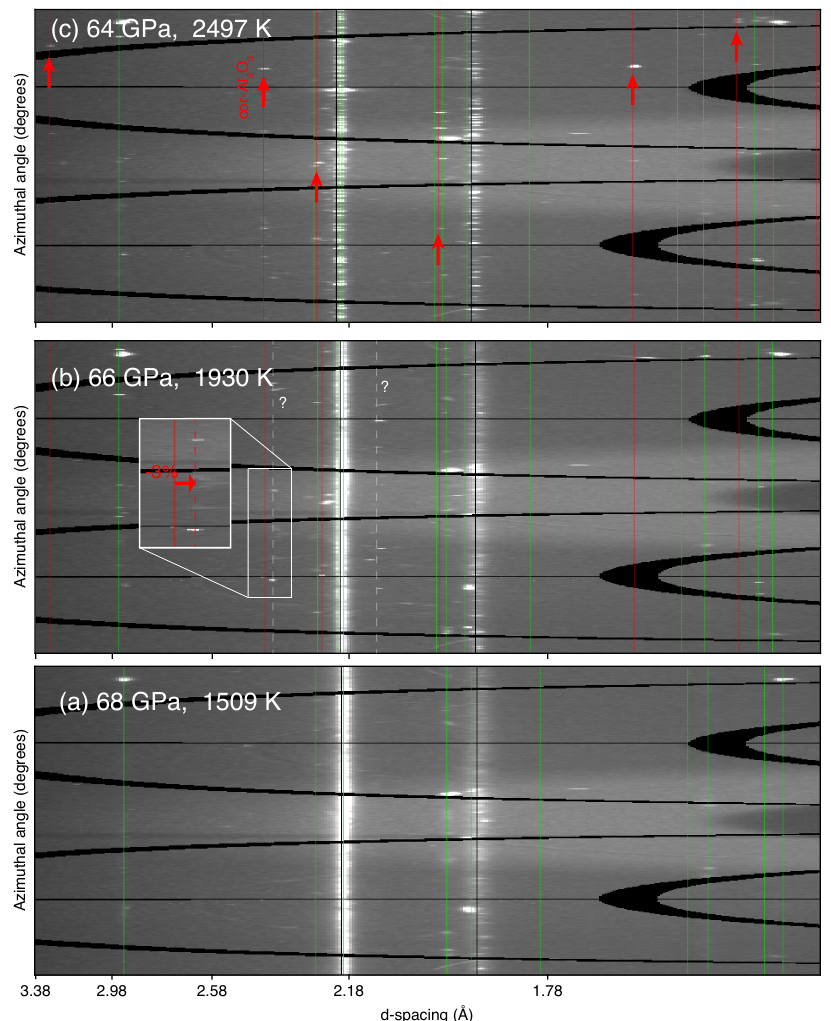
Figure A1. X-ray diffraction images for run #132B, where dehydration of δ -AlOOH occurs at 2497 K showing the formation of cor-Al 2 O 3 . X-ray energy was 30 keV. ( a ) At 1509 K, only precursor materials (i.e., δ -AlOOH, Ar and Au) are present; ( b ) at 1930 K, two unknown lines appear, one of which could belong to cor-Al 2 O 3 . However, as the inset shows, the unit-cell volume of cor-Al 2 O 3 would have to be 3% smaller than that expected at the P - T conditions; ( c ) at 2497 K, where dehydration of δ -AlOOH to cor-Al 2 O 3 occurs, lines belonging to the later can be clearly